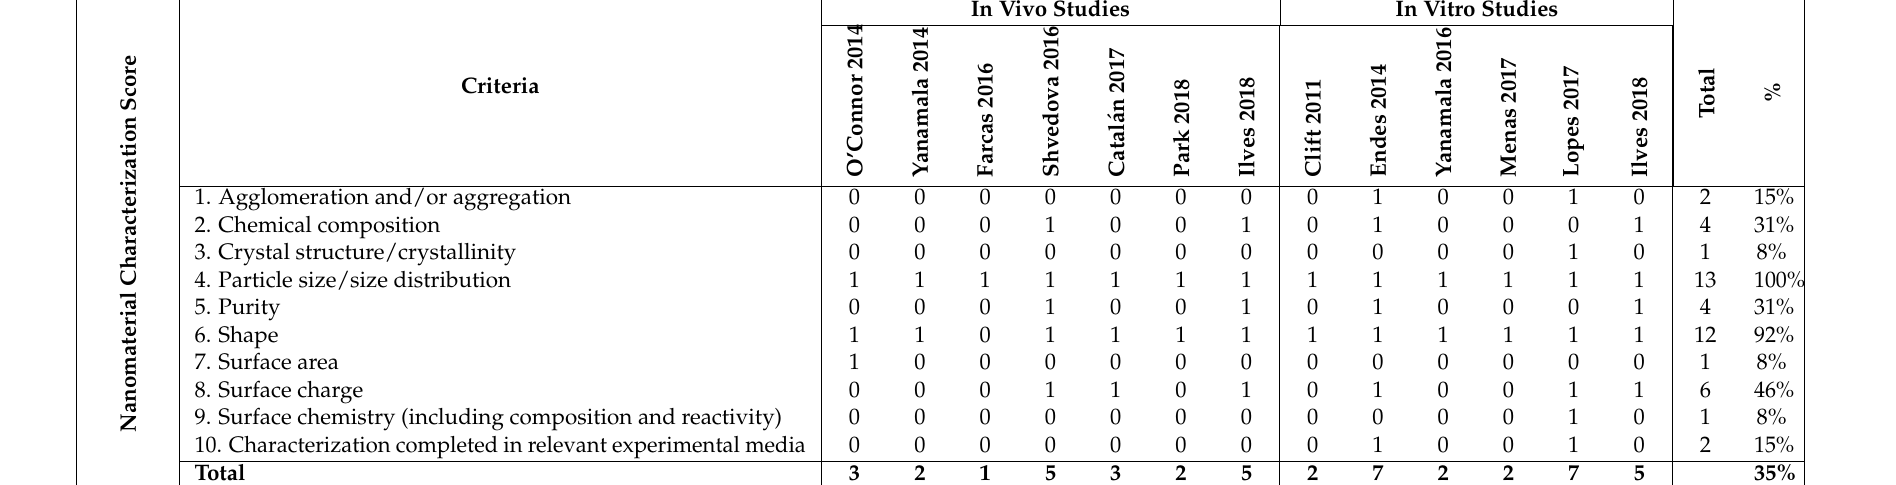
Table 3. Summary of Card and Magnuson nanomaterial score